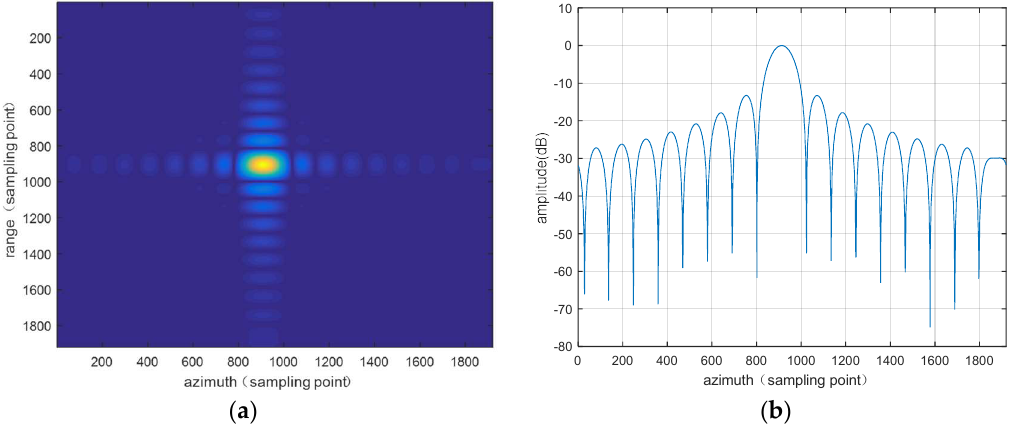
Figure 14. The simulation results for the 2° bistatic angle without the consideration of the TCR optimum boresight. ( a ) The point target image after upsampling 48 times; ( b ) the azimuth profile based on the results of the electromagnetic simulation.